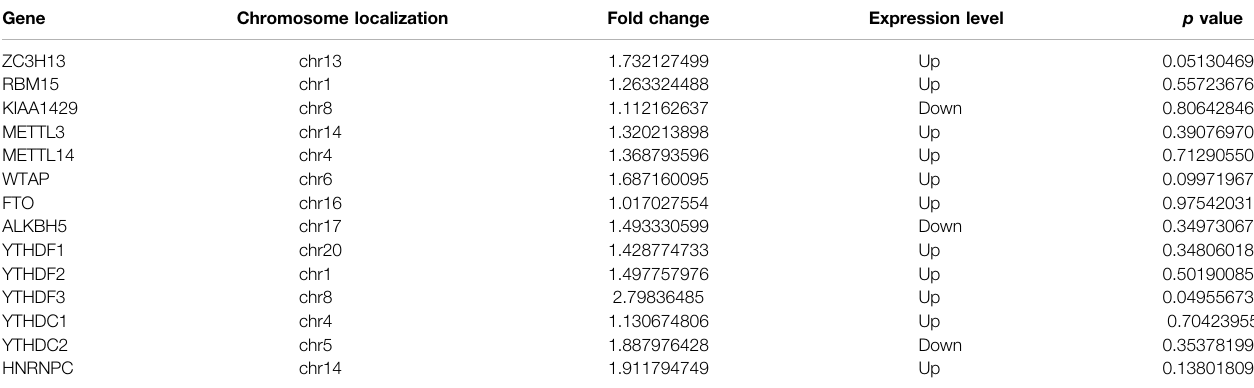
TABLE 8 | Expression of m 6 A methylated regulator.